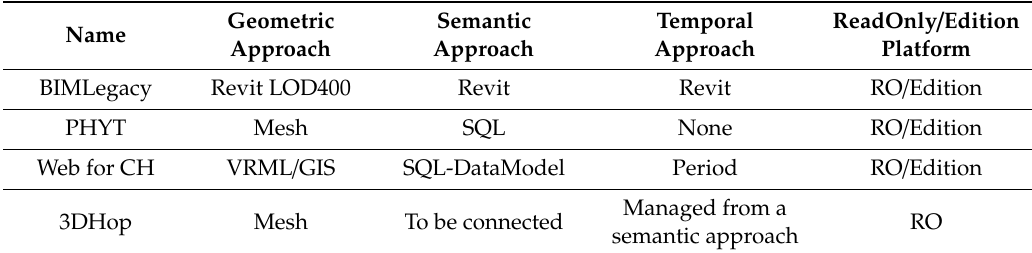
Table 1. Summary of cultural heritage management platforms approaches.